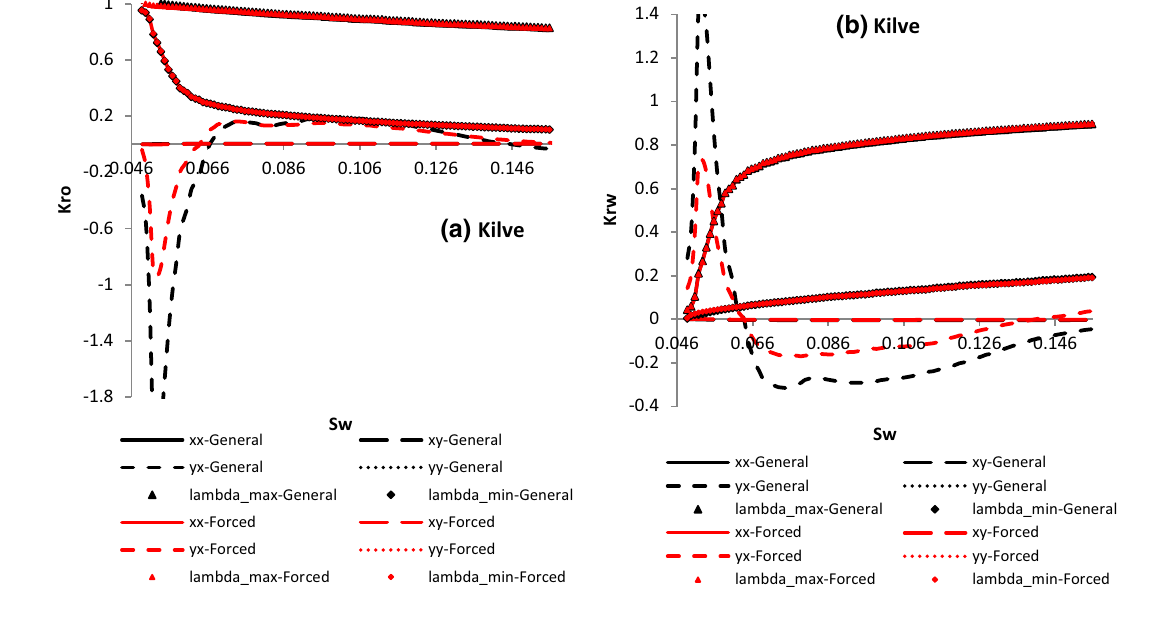
Fig. 4 Relative permeability tensor components for oil ( a ) and water ( b )